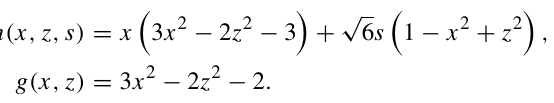
Fig. 12 Therearesevensubregionsinsidetheregion R 1 ofthePoincaré ball